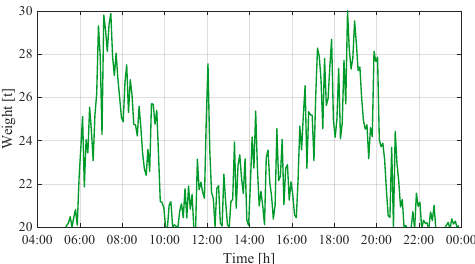
Figure 15. Estimated weight of the trolleybuses according to the period of the day. The plot covers the period from 04:00 to 24:00.